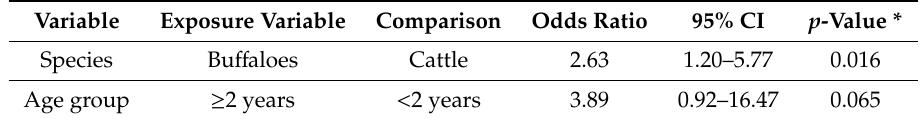
Table 4. Multivariable analysis at animal level for cattle and bu ff